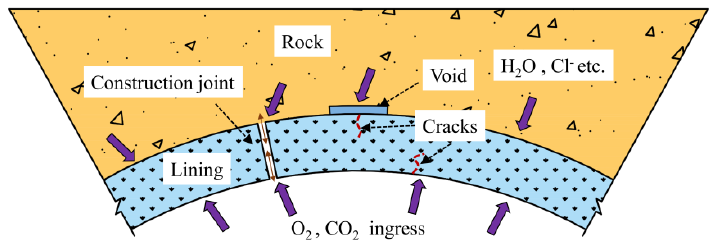
Figure 3. Typical working environment of a coastal tunnel.